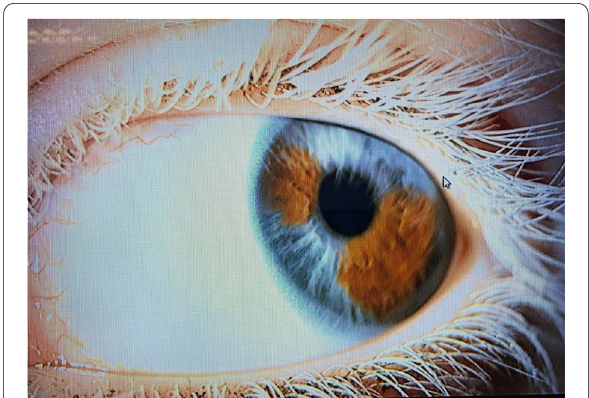
Fig. 3 The girl’s image (proband IV-1) which shows local iris hypo-pigmentation